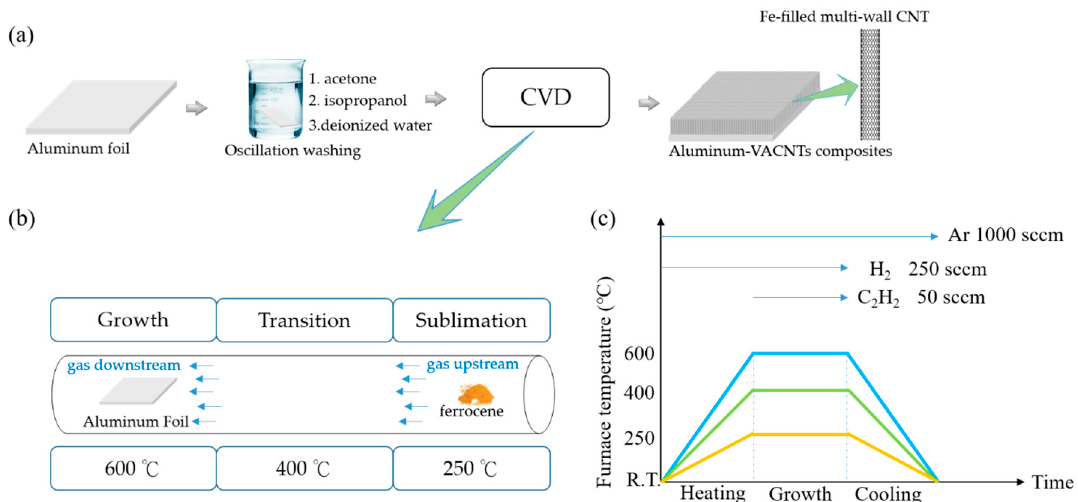
Figure 1. ( a ) Fabrication procedure of aluminum vertically-aligned carbon nanotube forests (VACNTs) composites; ( b ) synthesis setup in this experiment employing three-segment chemical vapor deposition (CVD); ( c ) recipes for the furnace and gas flow.